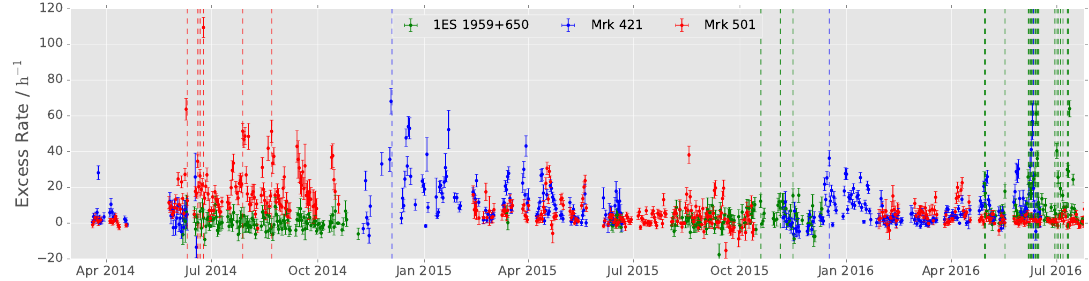
Figure 6. Excess rate curve for the three sources which FACT has sent flare alerts for. The flare alerts are marked with vertical